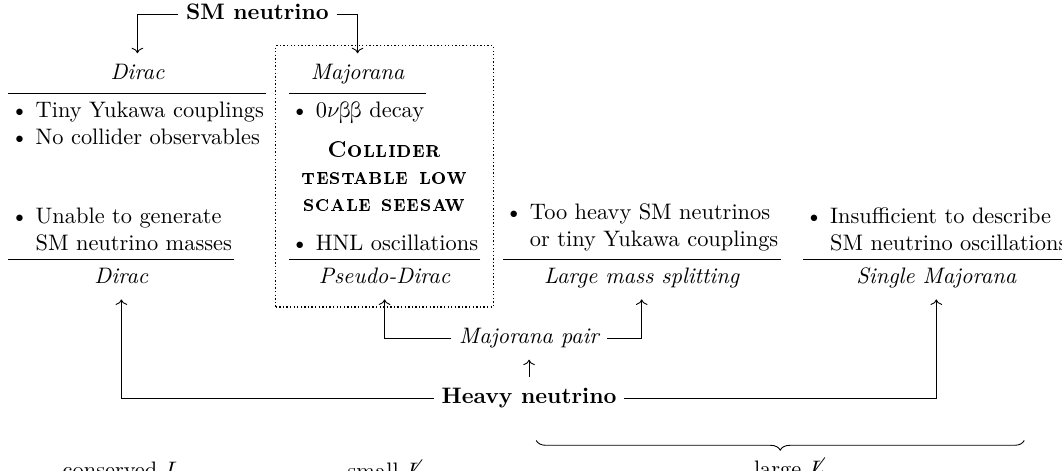
Figure 1 . Comparison between the different possible choices for active and sterile neutrinos discussed in the text. Note that for collider-accessible heavy neutrinos that generate Majorana masses for the light neutrinos via a low-scale seesaw with couplings far above the naive seesaw line, only pseudo-Dirac pairs of two nearly mass-degenerate Majorana DOFs are a viable